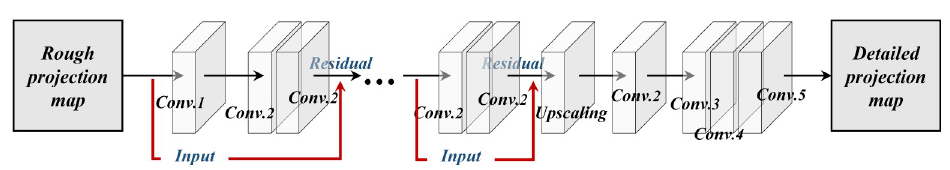
Fig 8. Feature extraction via denoising convolutional neural network (red arrow: Residual